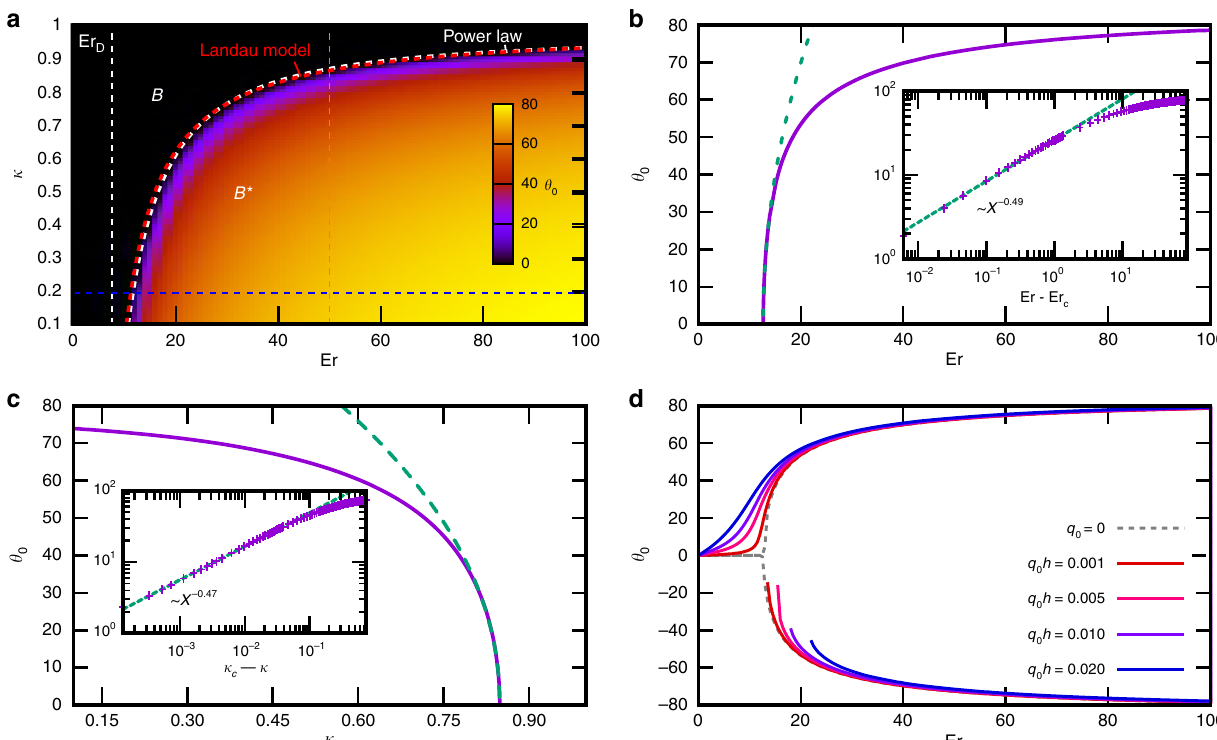
Fig. 6 Phase transition to the chiral state B * with respect to elastic anisotropy κ and Ericksen number Er . a B state appears in the phase diagram at large values of κ and at small values of Er. The B (cid:3) state is characterised by non-zero mid-channel tilt angle θ 0 of the director. The phase border is fi tted with the function κ ¼ (cid:1) A ð Er (cid:1) C Þ (cid:1) β þ D with exponent β ¼ 1 : 36, asymptote at Er ¼ 9 : 87 and κ ¼ 0 : 97. Er D ¼ 7 : 56 indicates the value of Ericksen number at which D phase can be stabilised. b , c Cross sections of the phase diagram at κ ¼ 0 : 2 and Er ¼ 50, respectively, show a clear continuous phase transition between B and B (cid:3) phase. In the vicinity of the transition region a power law reveals a critical exponent close to 0.5 (see insets). d Effect of intrinsic chirality on the mid-plane tilt angle θ 0 , obtained by numerical integration of Eq. (8). The symmetry of the pitchfork bifurcation at the second-order B to B (cid:3) phase transition is broken by a chiral dopant into stable and metastable branches. In a chiral system, the tilt angle has an immediate onset at small non-zero fl ow rates instead of an abrupt onset at the transition fl ow rate. The dotted line indicates the solution for no intrinsic pitch, shown also in b .